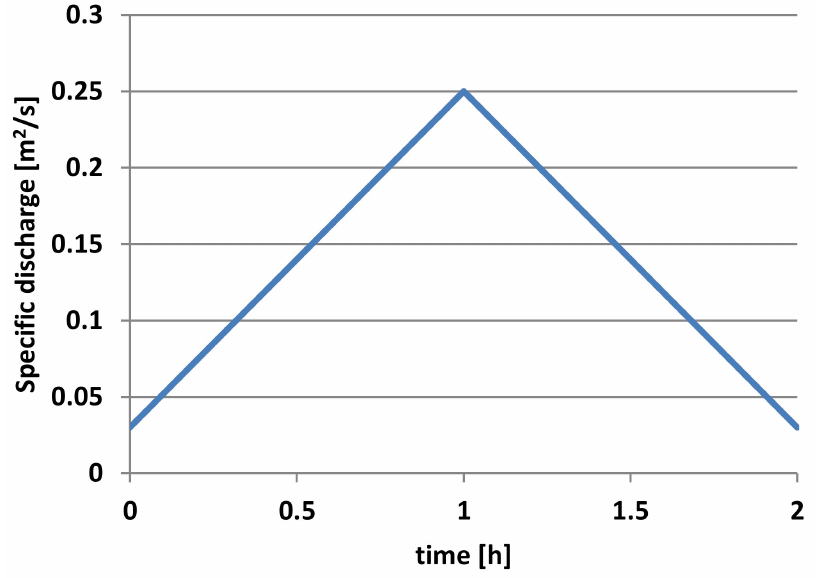
Figure 3. Hydrograph of scenario A4 after Shimizu et al. (2009)